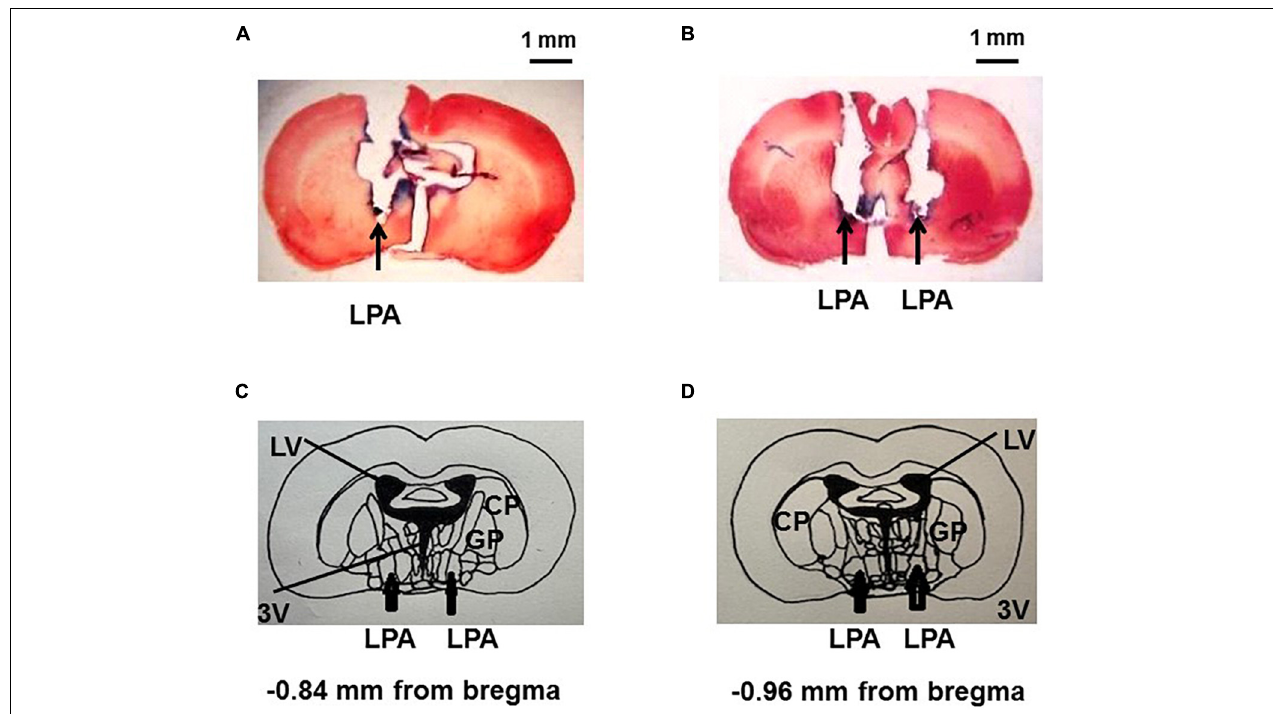
FIGURE 2 | Photomicrograph of histological sections (coronal), showing the drug injection site into the lateral preoptic area unilaterally (A) and bilaterally (B) marked with 4% Chicago Sky Blue dye (1 µ L). A schematic representation of the lateral preoptic area at –0.84 mm from bregma (C) and at –0.96 mm from bregma (D) is shown in the brain sections according to Paxinos and Watson (2009). The arrows indicate the location of the LPA. CP, caudate nucleus/putamen; GP, globus pallidus; LPA, lateral preoptic area; LV, lateral ventricle; SFO, subfornical organ; 3V, third brain ventricle. Amplification: 160 ×